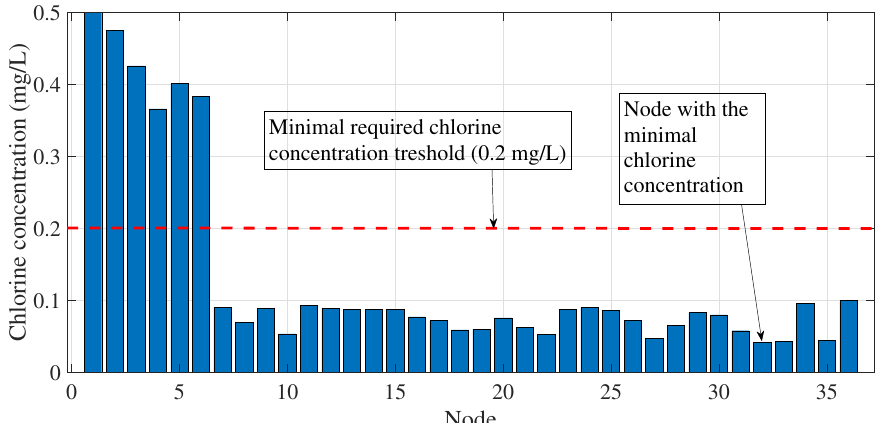
Figure 11. Minimal chlorine concentration at each node when s Q = 0.8 mg/L and i Q = is 0.5 mg/L. From Figure 11 it is clear that only nodes 1 to 6 comply with the normativity re-